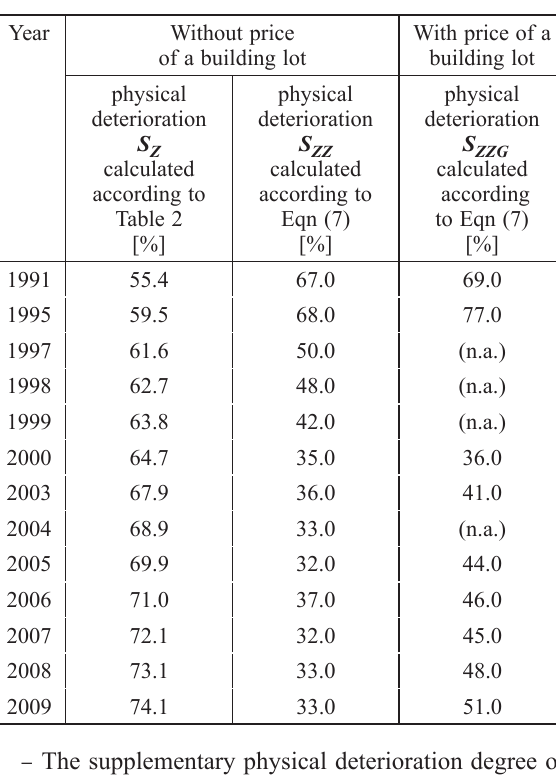
Table 4. The comparison of the real S Z and the supplementary